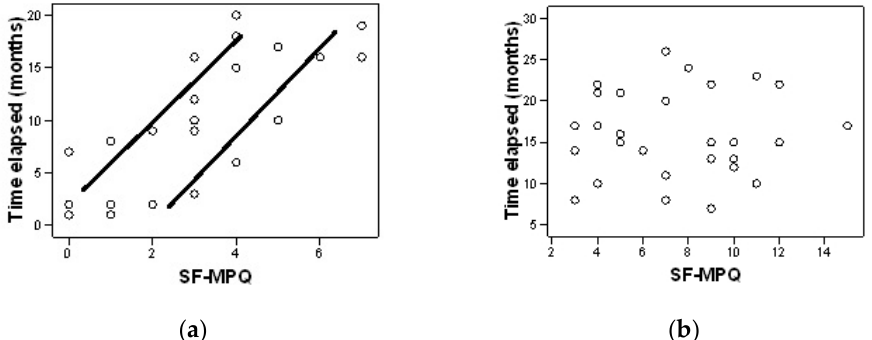
Figure 1. Correlation between the time elapsed from diagnosis and the level of pain after six months for the experimental group ( a ) and control group ( b ).